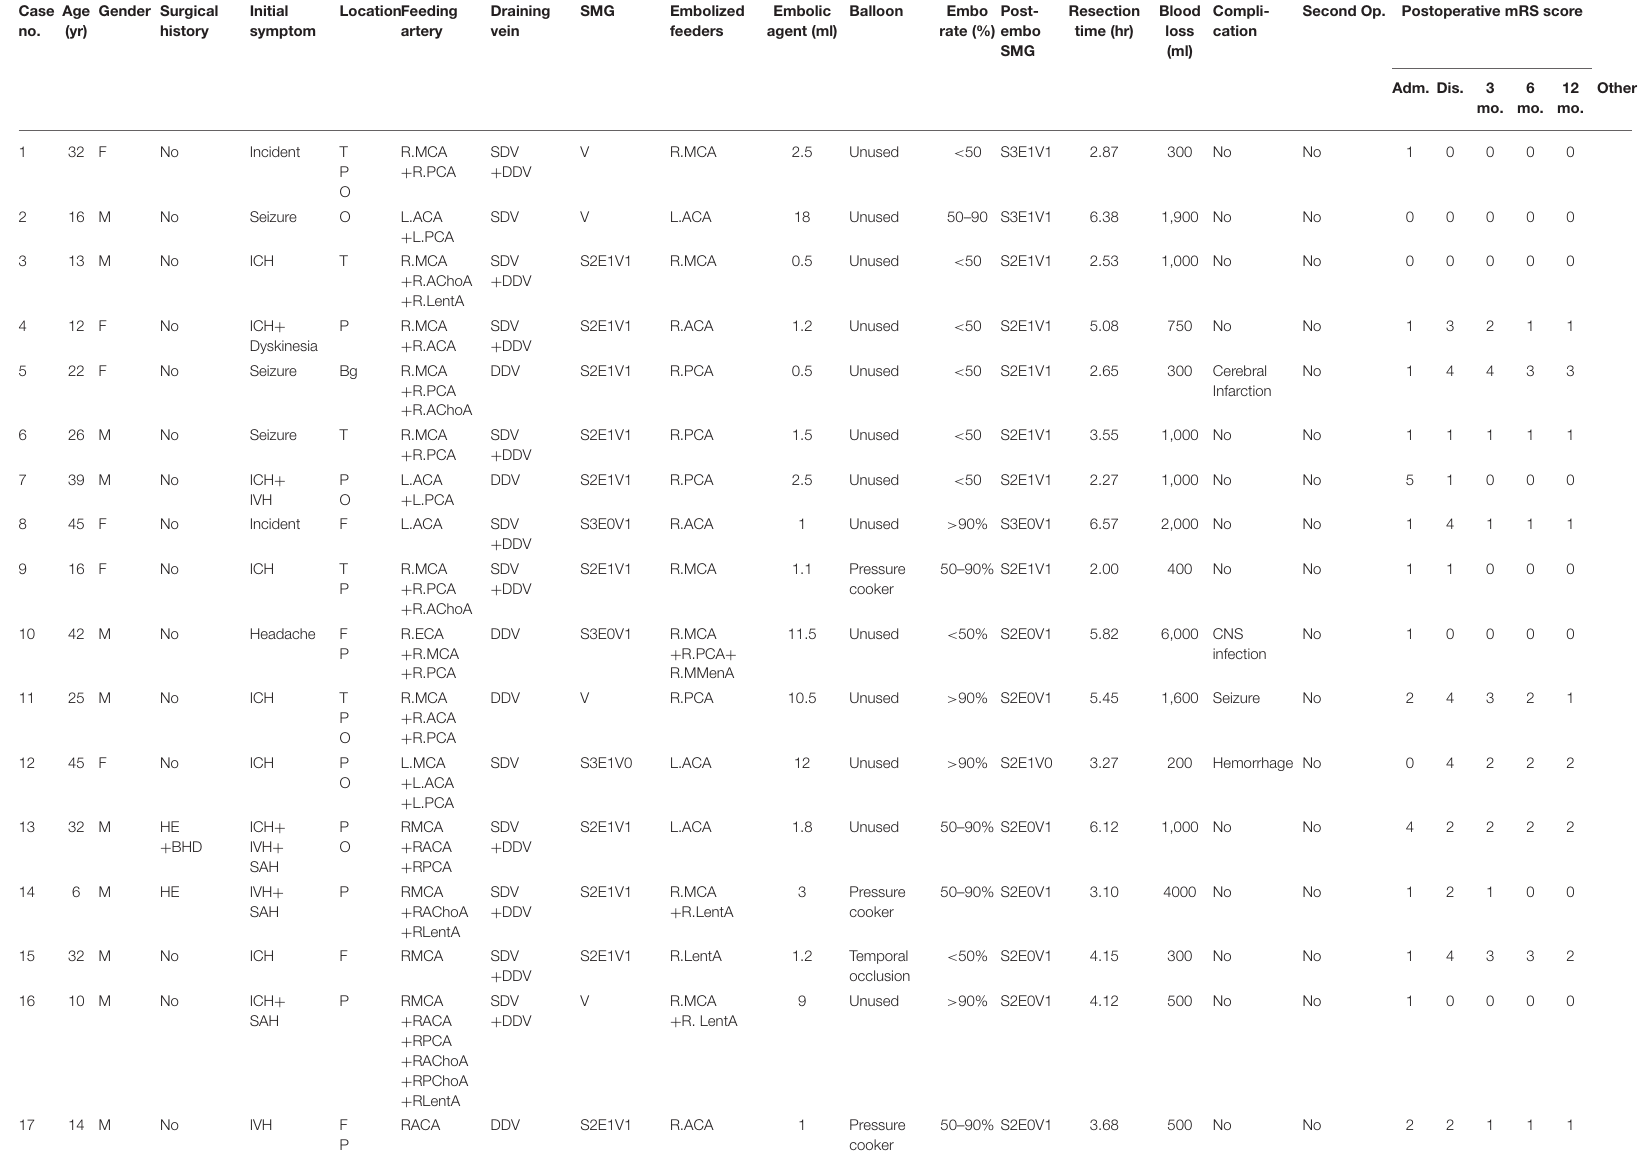
TABLE 2 | Summary of patients who underwent the paradigm of embolization plus simultaneous microsurgical resection. Case Age Gender Surgical no. (yr)